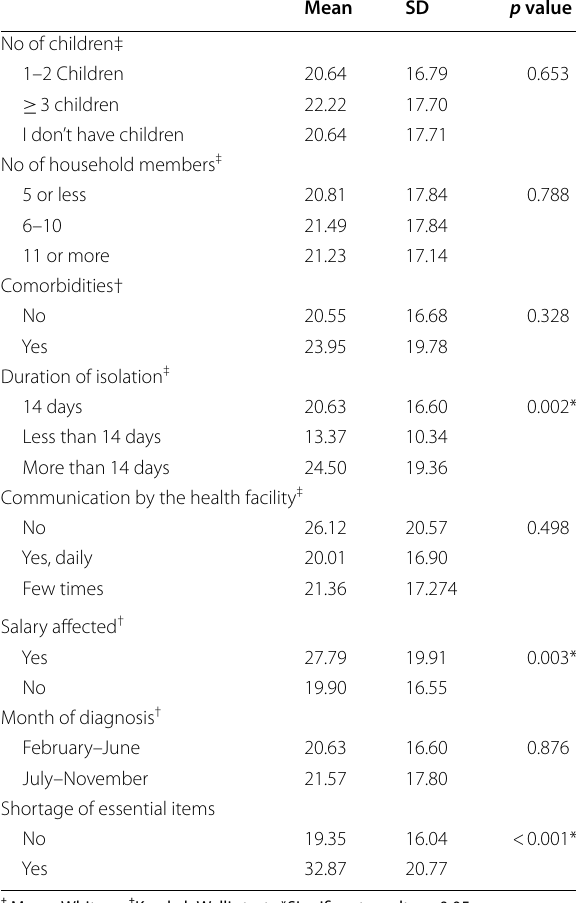
Table 5 Relationship between IES-R means and patients’